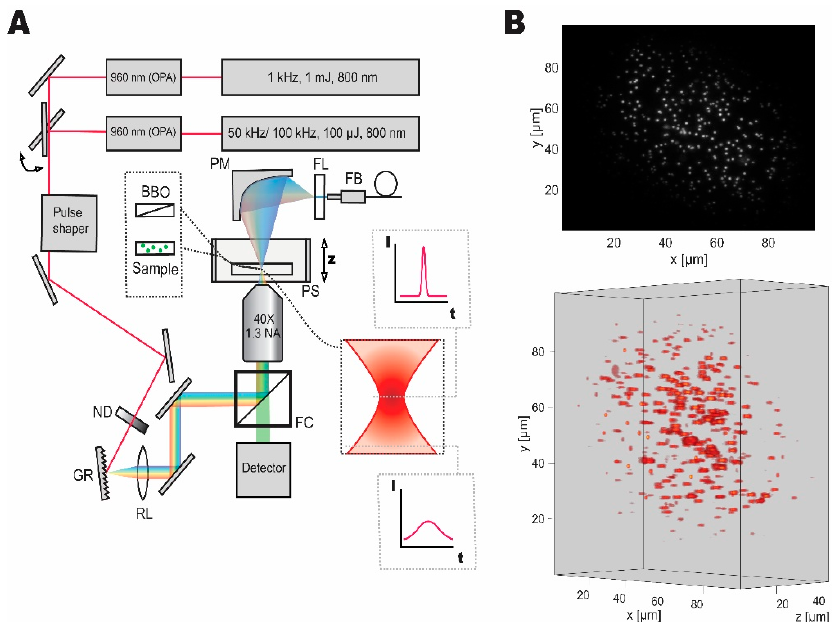
Figure 1. Dual laser setup for temporal focusing with pulse control and characterization capabilities. ( A ) Wide-field temporal focusing microscopy setup comprised of a grating (GR), relay lens (RL), and an objective lens was coupled to two laser systems with different repetition rates, that can be switched between with a flip mirror. Imaging samples were mounted on a high-speed piezo stage (PS). Discrete neutral density filter wheel (ND) was used to control the average power of optical excitation on the sample. During imaging experiments, the filter cube (FC) was used to separate the fluorescent signal for detection. For pulse shape characterization the second harmonic signal from a nonlinear crystal (BBO) mounted on a microscope slide was collected by a parabolic mirror (PM) passed through a filter (FL) and coupled to the fiber (FB) spectrometer of the pulse shaper for characterization and compression. ( B ) Grayscale two-dimensional and volumetric reconstructions of the fluorescent micro-bead sample demonstrating the Gaussian distribution of excitation light and accessible volume and